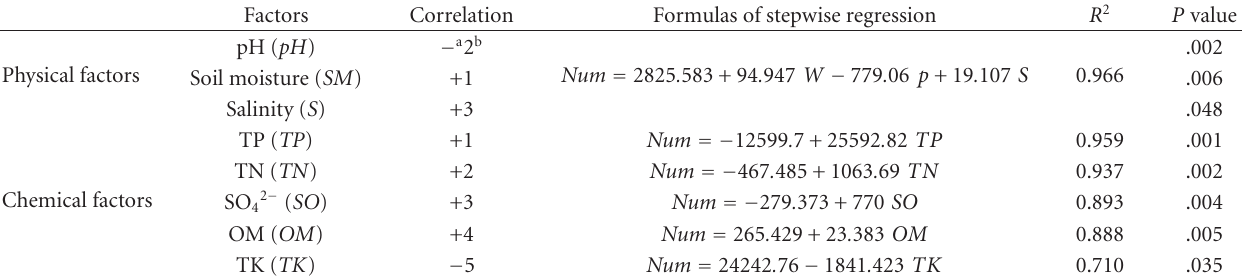
Table 6: Correlation of ciliate abundance with soil physical/chemical properties in dried samples.